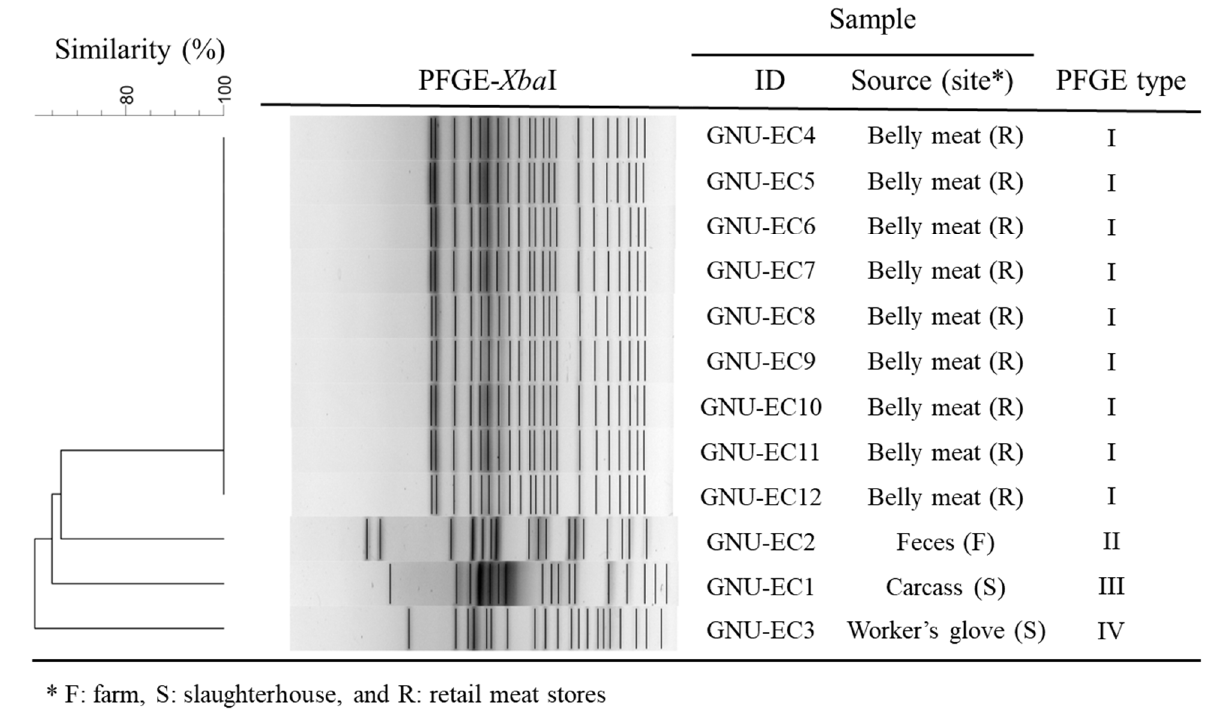
Figure 2. Analysis of PFGE banding patterns of STEC strains isolated from feces at swine farm, carcass, and the workers’ gloves at meat processing plant, and belly meats at retail stores. Dendrogram of the PFGE patterns from 12 STEC meat and environmental isolates using Xba I-digestion is shown by 4 pulsotypes according to the similarity of PFGE band profiles of more than 99% within a group using UPGMA clustering method.